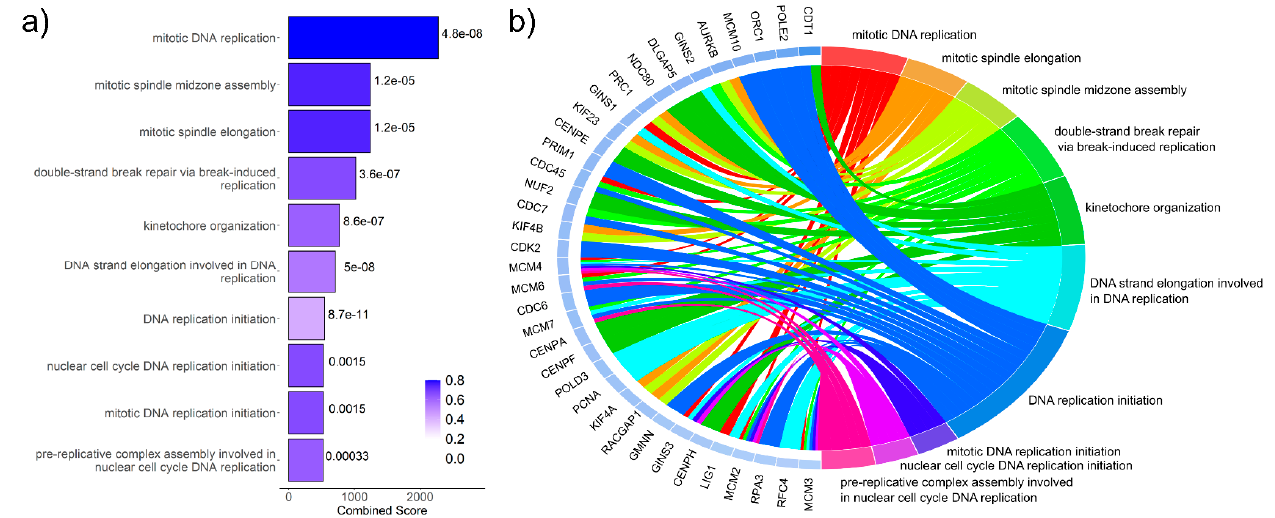
Figure 7. Significant gene ontology term enrichment in Ento+AZD exposed SU-DHL-4 cells by RNAseq. Significant gene ontology (GO) enrichment analyses by Enrichr in Ento+AZD exposed SU-DHL-4 cells. ( a ) Top 10 significantly enriched GO terms of underexpressed genes after Ento+AZD exposure. GO terms were ranked by the combined score. The color gradient indicates the decreasing fraction of significant genes, while darkest color represents the highest significant fraction of genes. <0.05 = significant. n.s. = not significant. ( b ) Chordplot of top 10 enriched GO terms of underexpressed genes. GO terms were ranked by combined score and top 10 significantly downregulated GO terms are illustrated and linked to the significant DEGs. The genes are ranked by logFC, with the relative strength of the logFC indicated by the color adjacent to the gene name (blue indicates underexpression, and a darker color indicates a stronger logFC).